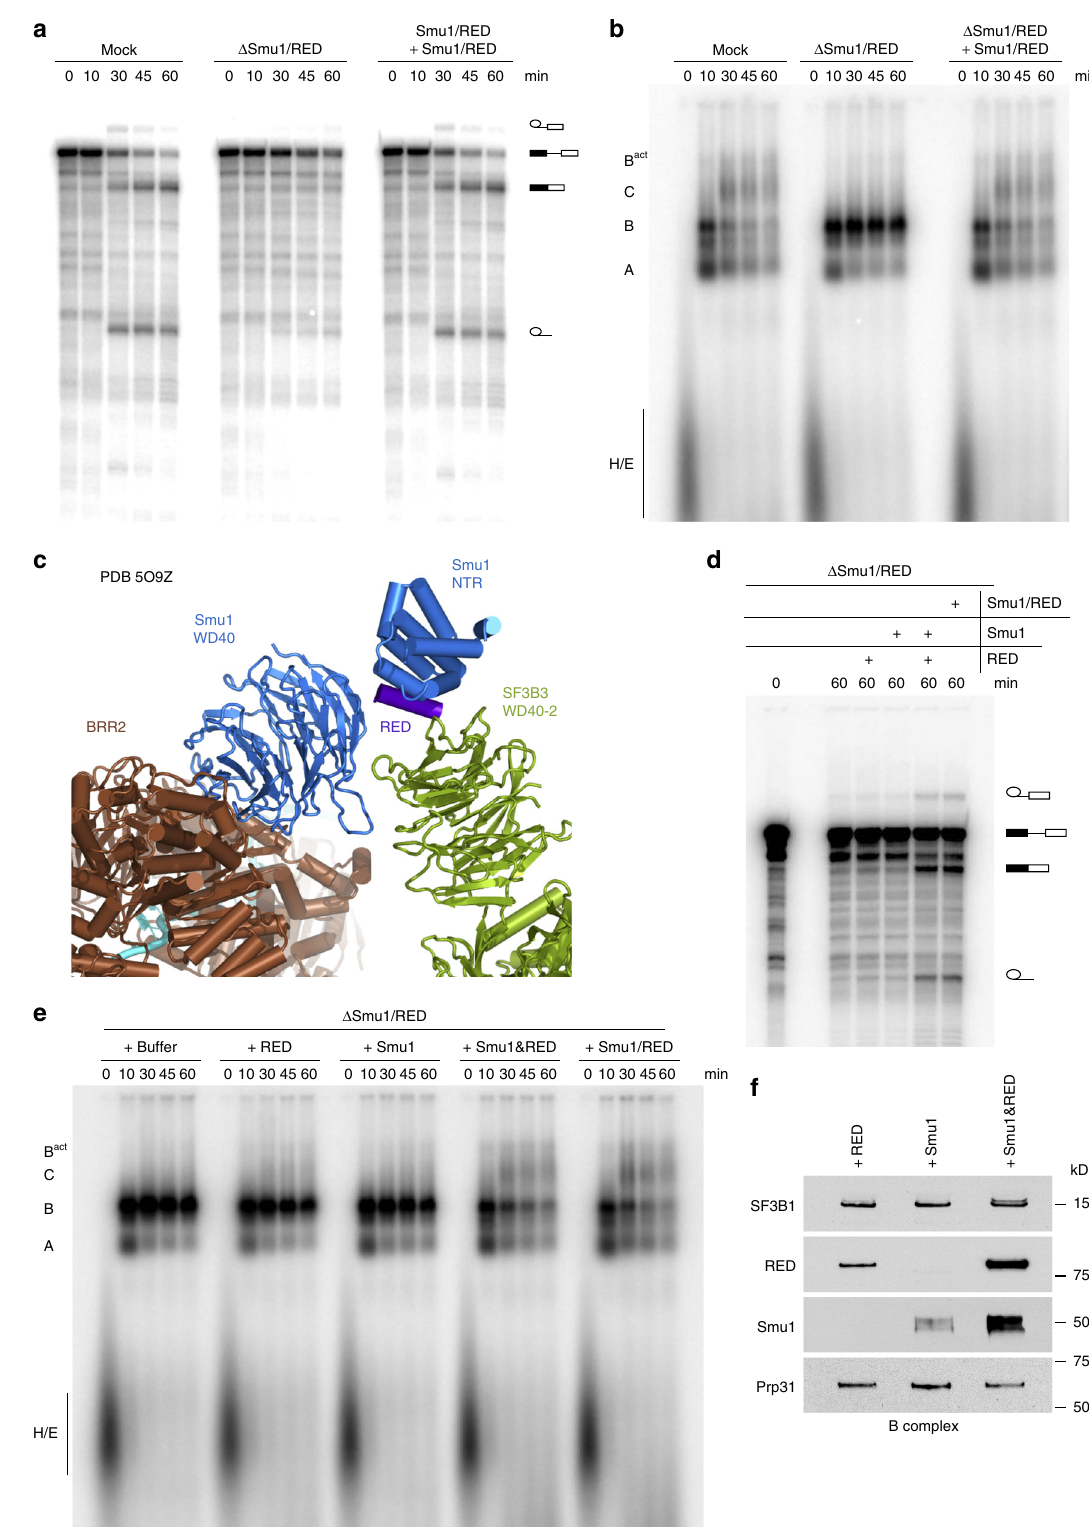
transcribing MINX80 in two independent parts (cut-MINX80) (Fig. 6a). The fi rst comprised the 5 ′ exon plus 25 downstream intron nucleotides, and the second contained 31 nucleotides upstream of the BS, the BS, PPT and 3 ′ exon. As in this case only the 5 ′ exon is radiolabelled, the intron-3 ′ exon intermediate and